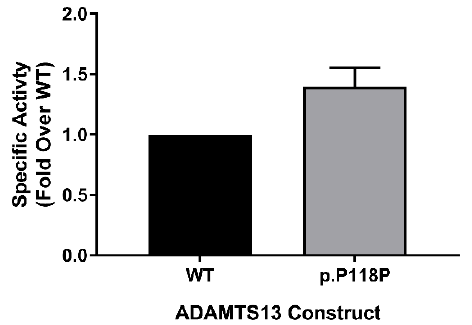
Figure 4. Specific activity assessment. Activity of equimolar concentrations of wild-type (WT) and p.P118P variant ADAMTS13 was measured by FRETS-VWF73 activity assay. Specific activity of p.P118P variant was higher than WT ADAMTS13. Each bar ( n = 3) represents mean activity (±standard